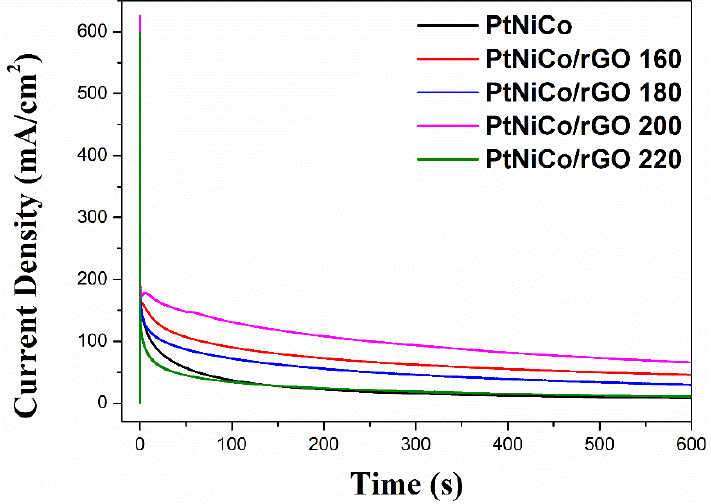
Figure 11. Chronoamperometric curves of PtNiCo, PtNiCo/rGO 160, PtNiCo/rGO 180, PtNiCo/rGO 200, and PtNiCo/rGO 220 in 0.5 M H 2 SO 4 + 1.0 M CH 3 OH solution at constant potential of 0.70 V.